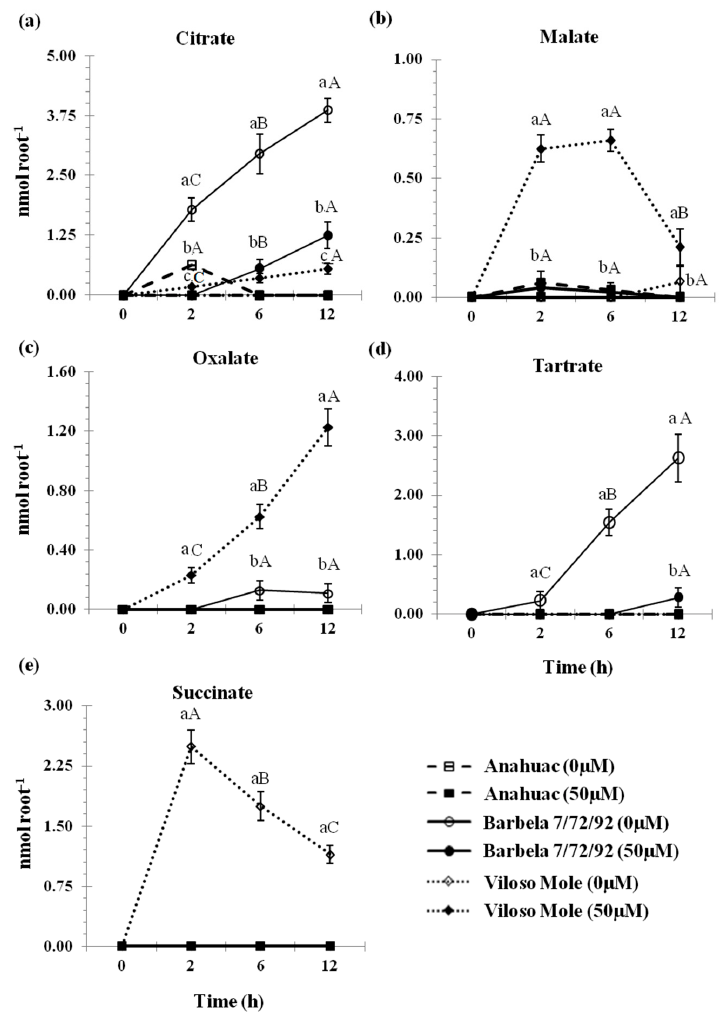
Figure 4. Pattern of OAs secretion from the intact roots of bread wheat genotypes; Anahuac, Barbela 7/72/92 and Viloso Mole. Roots were exposed to control (0 μ M Al) or Al stress (50 μ M Al). Root exudates were collected at specific intervals (0, 2, 6 and 12 h) for the determination of individual OAs. Vertical lines on the graph indicate mean ± SE ( n = 6). ( a ) Citrate; ( b ) Malate; ( c ) Oxalate; ( d ) Tartrate; ( e ) Succinate. Means with different lowercase letters (a, b, c) represent significant differences among the treatments at specific time point whereas means with different capital letters (A, B, C) represent significant differences among the time point intervals at the p ≤ 0.05, according to Tukey’s test.